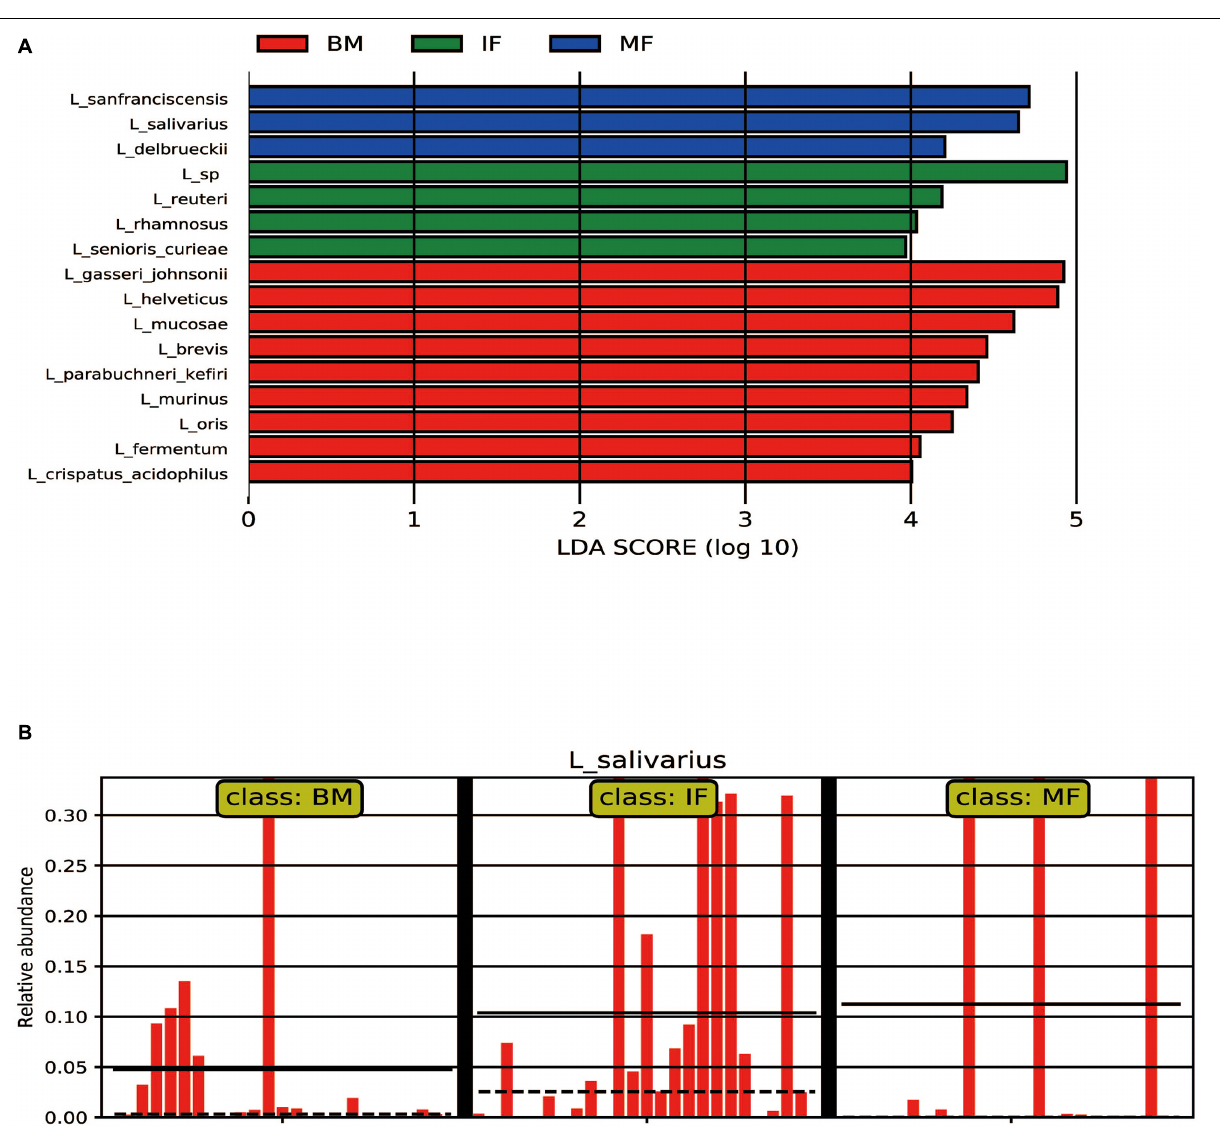
FIGURE 2 | LEfSe analysis of microbiota. (A) LEFSe plots showing differences between the maternal and infant lactobacilli of participants. The histograms show the linear discriminant analysis (LDA) scores of bacteriome at the specie level. The length of the histogram represents the LDA score. Breast milk samples (BM) have a higher relative abundance of the taxa shown in red, infant fecal samples (IF) have a higher relative abundance of the taxa shown in green, while maternal fecal samples (MF) have a higher relative abundance of the taxa shown in blue. (B) The relative abundance of L. salivarius among the BM group ( n = 25), IF group ( n = 25), and MF group ( n =